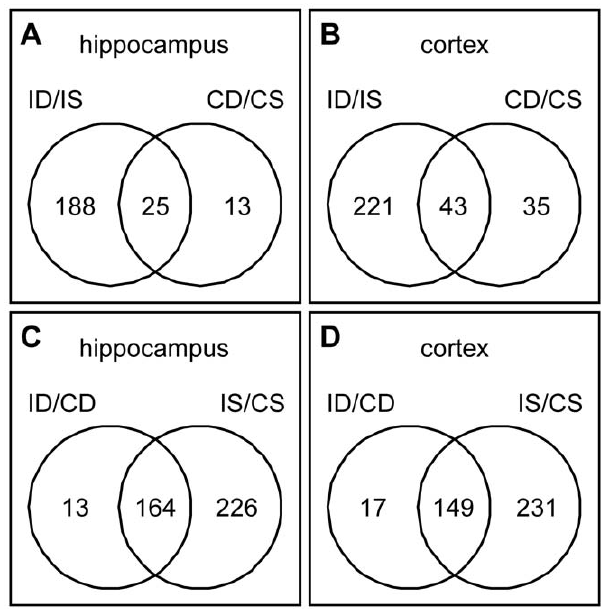
Figure 3. Venn diagrams showing the relation of the number of genes of defined comparisons. The numbers in the left or right part of the circles represent the number of regulated genes in the given comparison. The number in the intersection of both circles represents the number of genes regulated in both comparisons. The influence of the treatment in infected vs. control animals within the hippocampus (A) and cortex (B) is shown. The intersection shows the number of genes which are regulated by the treatment irrespective of the infection. The influence of the infection in dexamethasone vs. saline treated animals within the hippocampus (C) and cortex (D) is shown. The intersection shows the number of genes regulated by the infection irrespective of the treatment. I=infected animals, D=dexamethasone treatment, S=saline treatment, C=control animals.